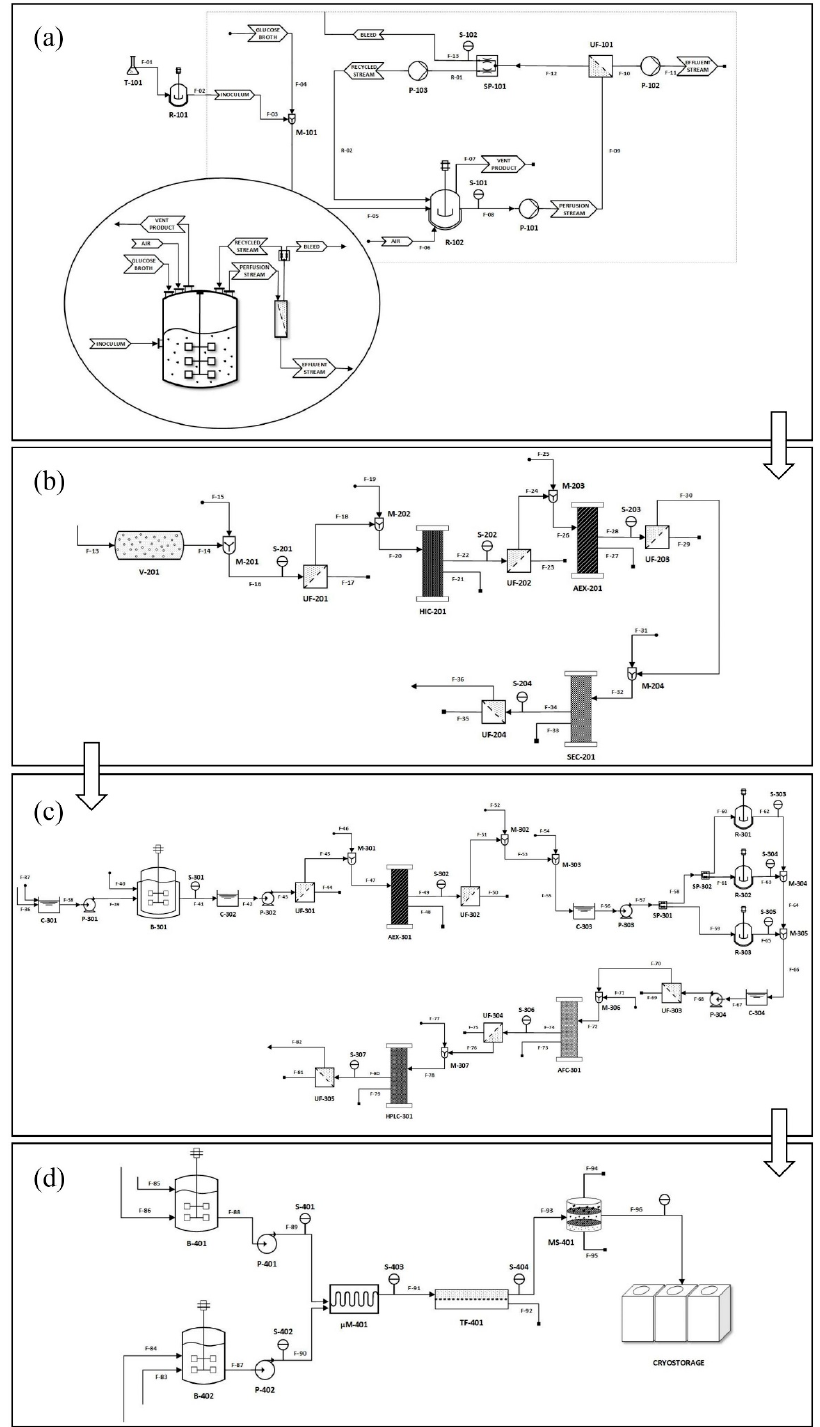
Figure 1. Process flow diagram of ( a ) perfusion bacterial culture upstream; ( b ) cell lysis and plasmid purification; ( c ) linearization and in vitro transcription; ( d ) lipid nanoparticle microfluidic formulation.